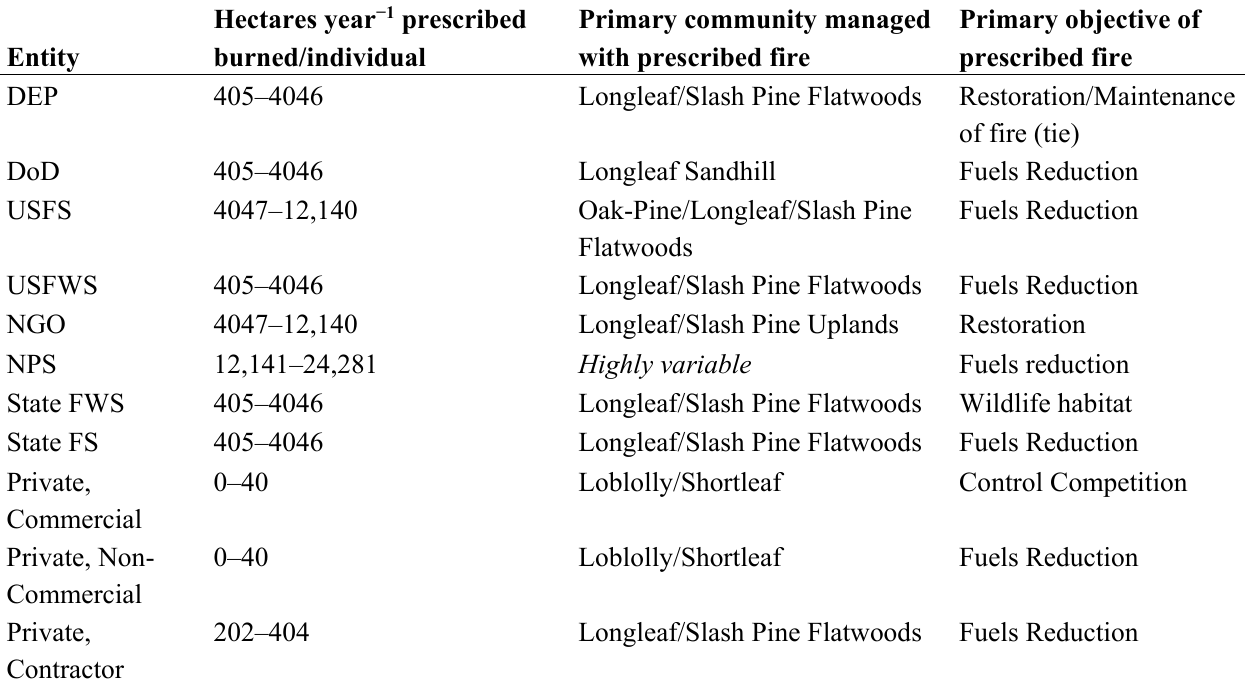
Table 3. Summary of most frequently chosen response by land